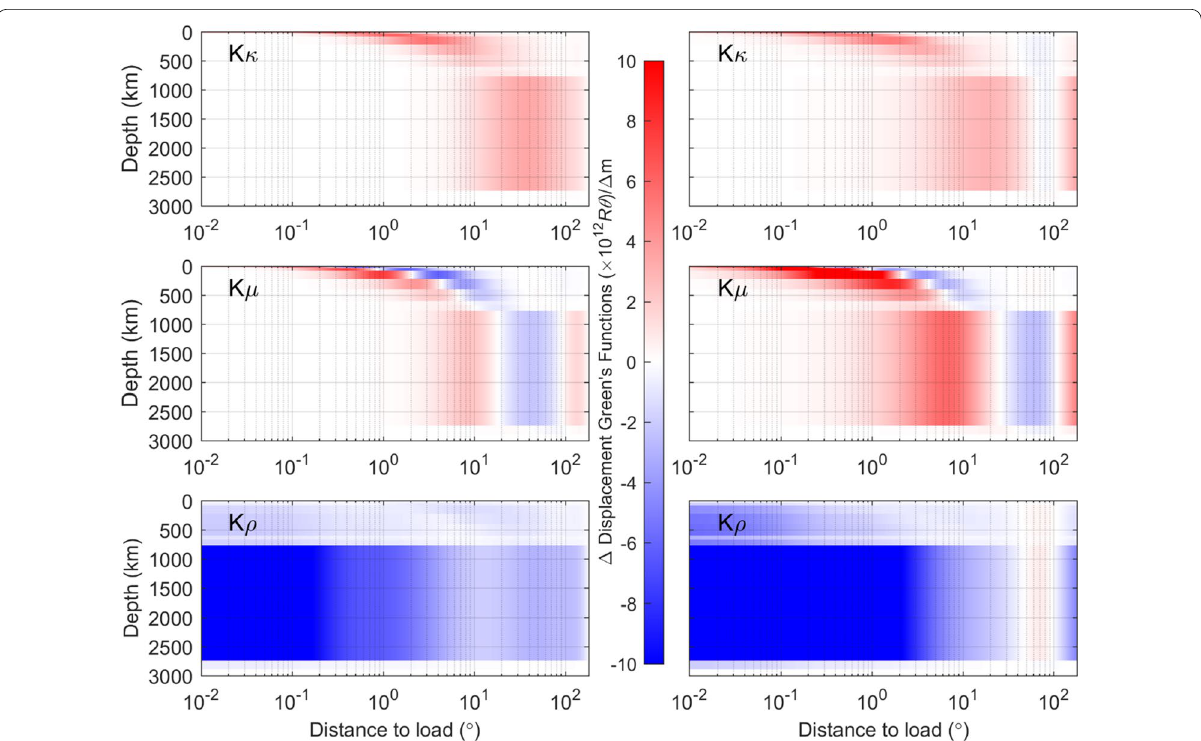
Fig. 4 The sensitivities of displacement Green’s functions to 1% linear perturbations of TW1. The displacement Green’s functions in the horizontal + (left) and vertical (right) components are scaled by 10 12 Rθ in the CE frame. We perturb the bulk modulus (top row), shear modulus (middle row), and density (bottom row) separately in the upper crust at depths of 0–13.88 km, the middle crust at depths of 13.88–24.52 km, the lower crust at depths of 24.52–32.15 km, the LID at depths of 32.15–80 km, the low-velocity zone (LVZ) at depths of 80–220 km, the region above the transition zone at depths of 220–400 km, the transition zone at depths of 400–600 km, the transition zone at depths of 600–670 km, the lower mantle at depths of 670–771 km, the lower mantle at depths of 771–2741 km, and the lower mantle at depths of 2741–2891 km from